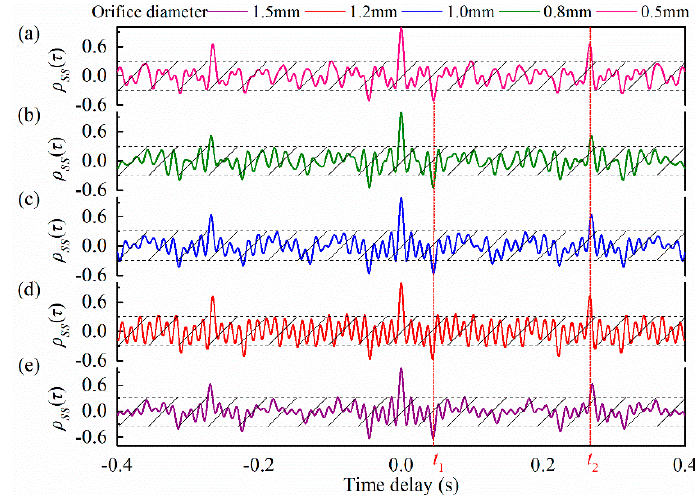
Figure 16. Autocorrelation coefficients of leak acoustic signals generated at orifice diameters of ( a ) 0.5